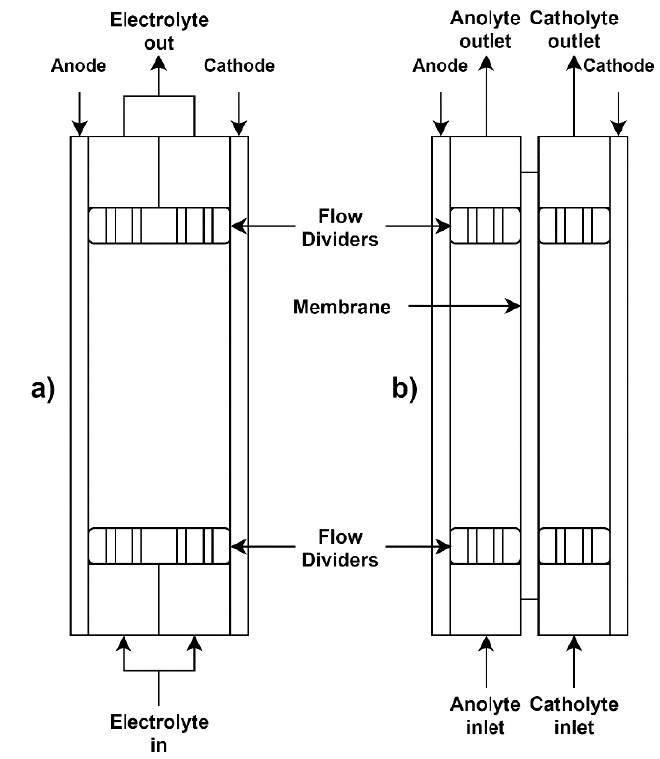
Figure 1. Diagram showing both the unseparated flow cell ( a ) and the membrane separated flow cell ( b ).